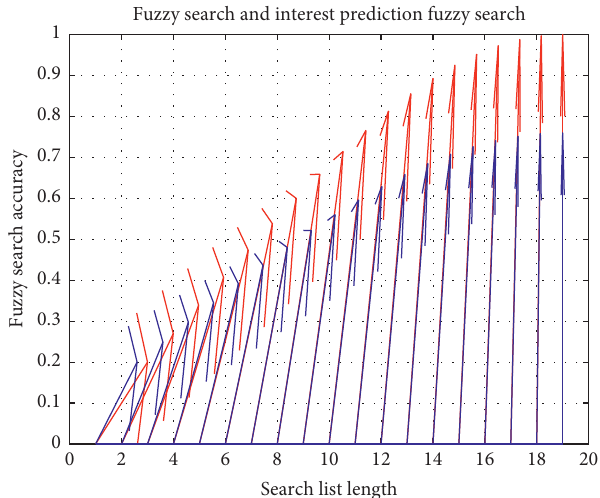
Figure 9: Fuzzy search accuracy after syntax